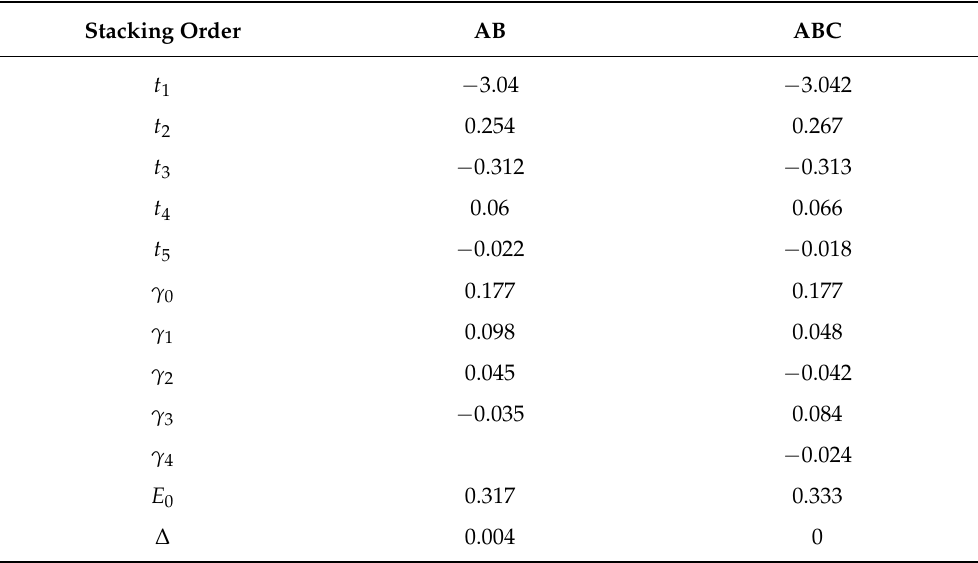
Table A1. TB parameters for AB stacking and ABC stacking graphite. All values are in eV. The TB Hamiltonian is valid in the whole three-dimensional Brillouin zone of